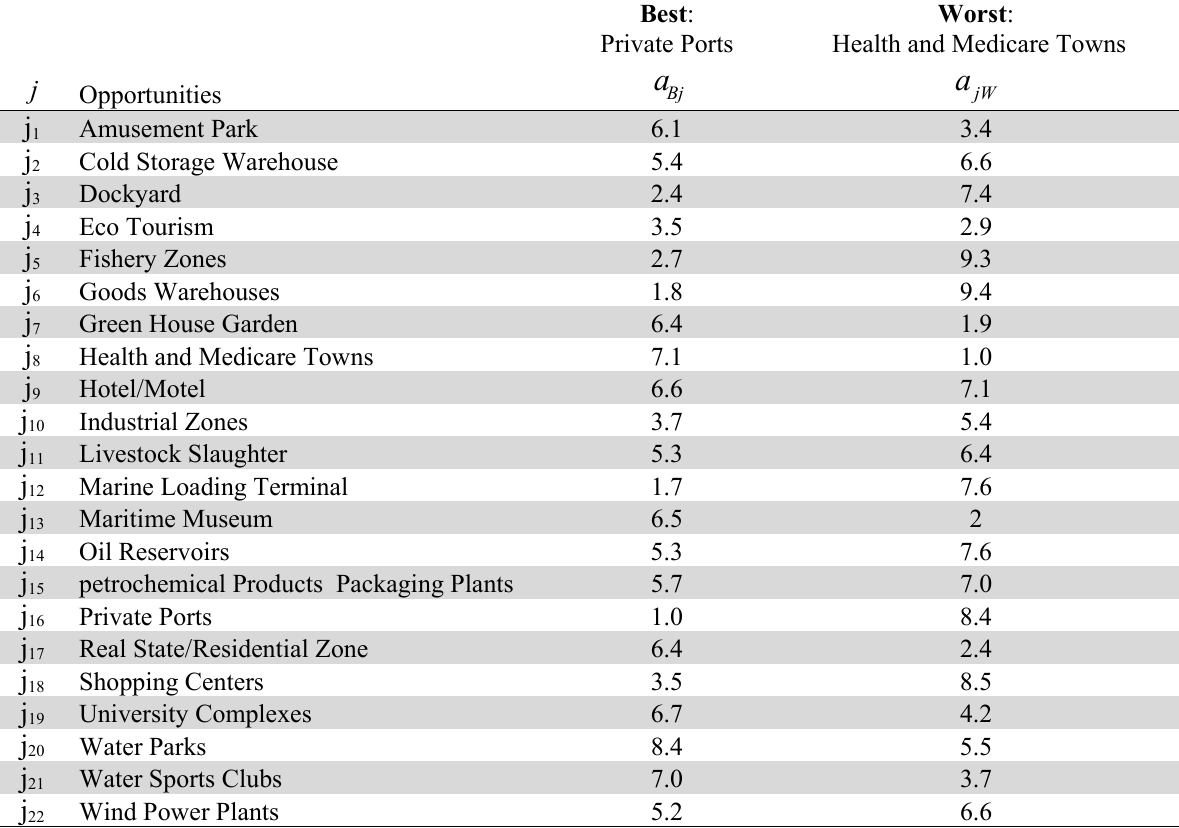
Average values of the experts in the field of identified opportunities to the Mokran